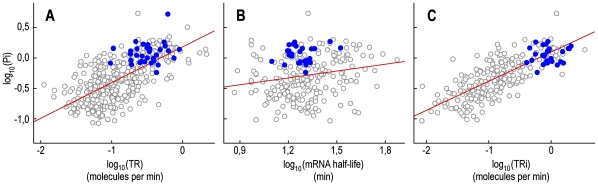
Pi versus rates of transcription and mRNA degradation in S. cerevisiae.Scatter plots of Pi versus transcription rate (TR) (panel A), Pi versus mRNA half-life (panel B) and Pi versus an indirect estimate of the transcription rate (TRi) (panel C). All values are log-transformed. Blue circles represent genes belonging to the ontology category “structural constituent of the ribosome”.